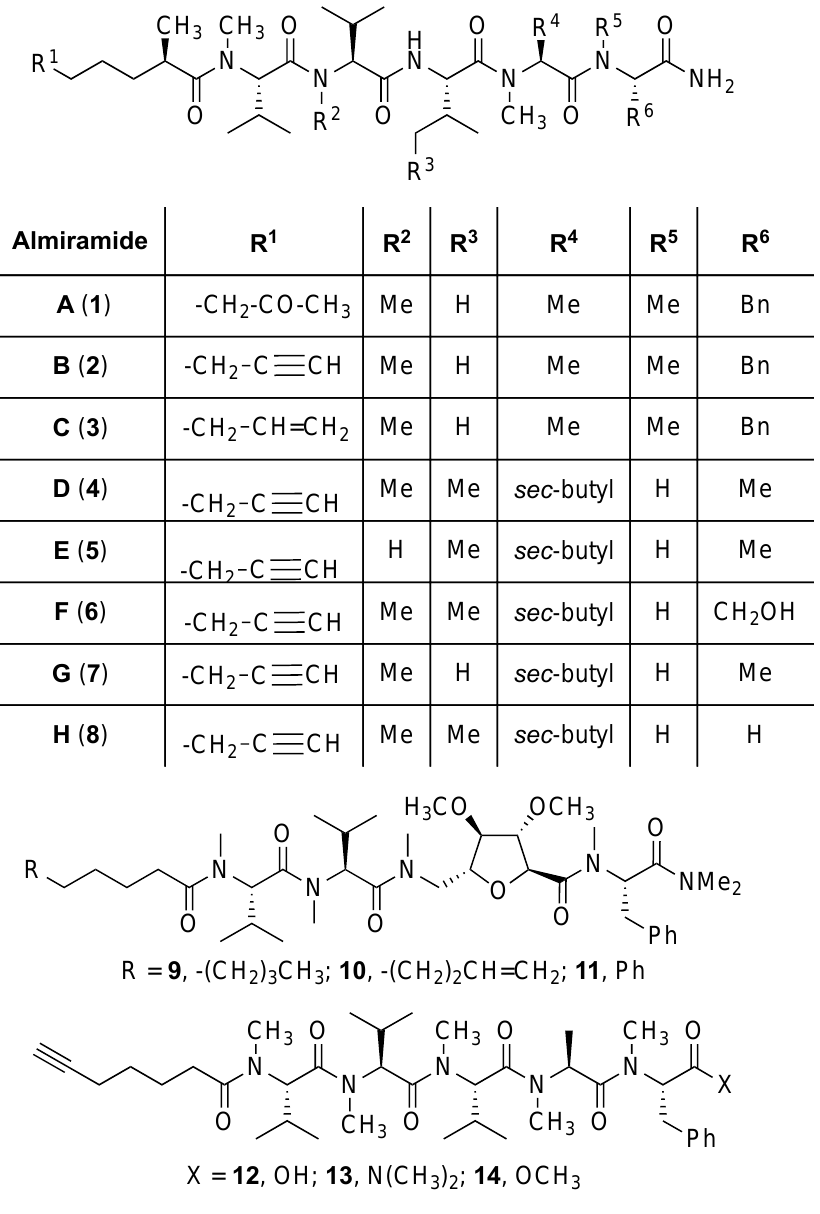
Figure 1. Natural almiramides A-H ( 1 – 8 ) and carbohydrate and C -terminal derivatives 9 – 14 .